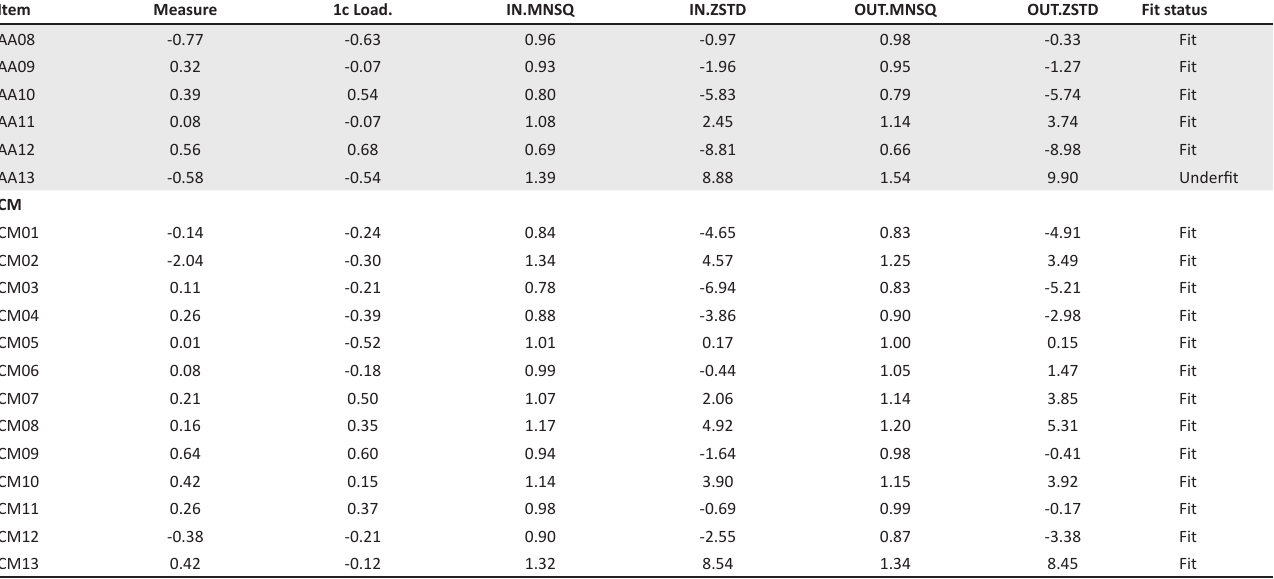
TABLE 4 (Continues…): Item statistics and fit status. Item